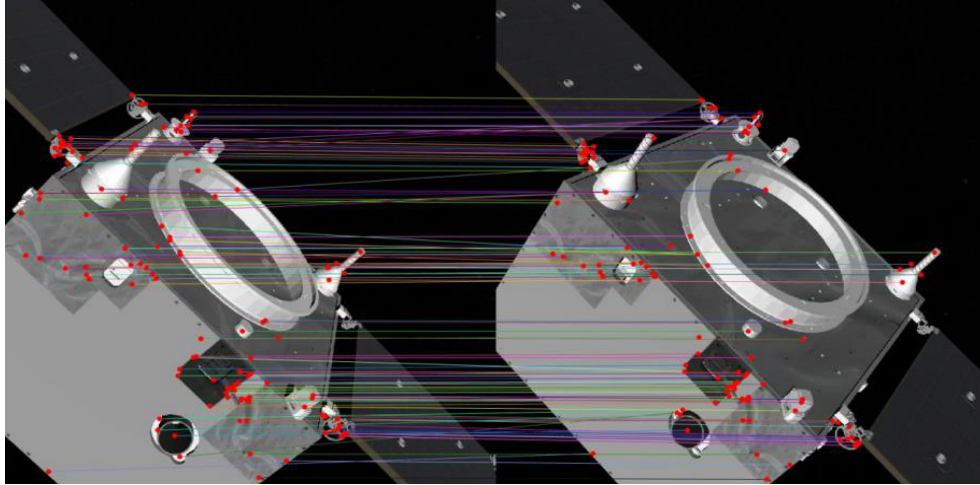
Figure 14. Feature matching based on convergent binocular stereo vision.